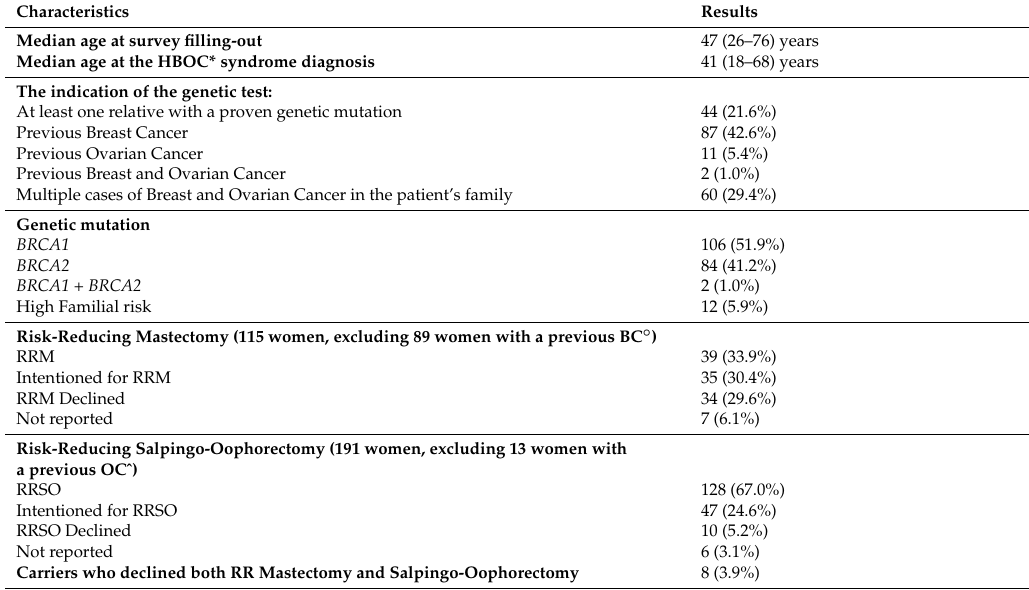
Table 1. Details on Risk-Reducing Surgery and medical history of women with Hereditary Breast and Ovarian Cancer (HBCO) syndrome included in the